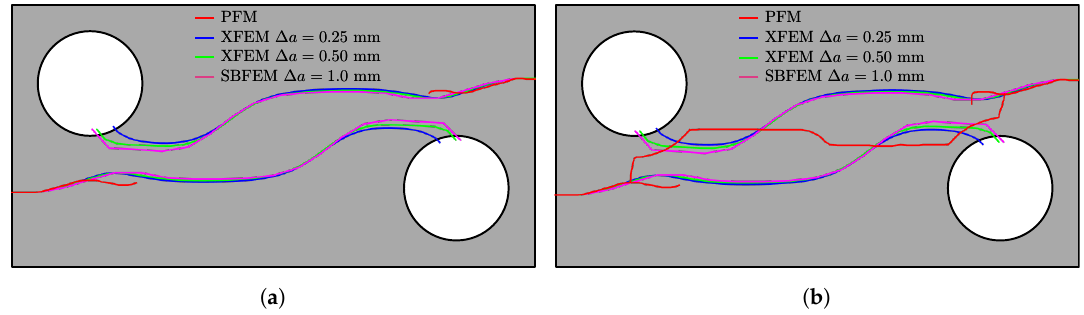
Figure 40. Crack path overlay for three variants: XFEM employing a fine mesh with ∆ a = 0.25 mm (pink), a coarse mesh with ∆ a = 0.50 mm (green) and SBFEM employing an adaptive mesh with ∆ a = 1.00 mm (orange). ( a ) Prior to crack nucleation at the holes; ( b ) After crack